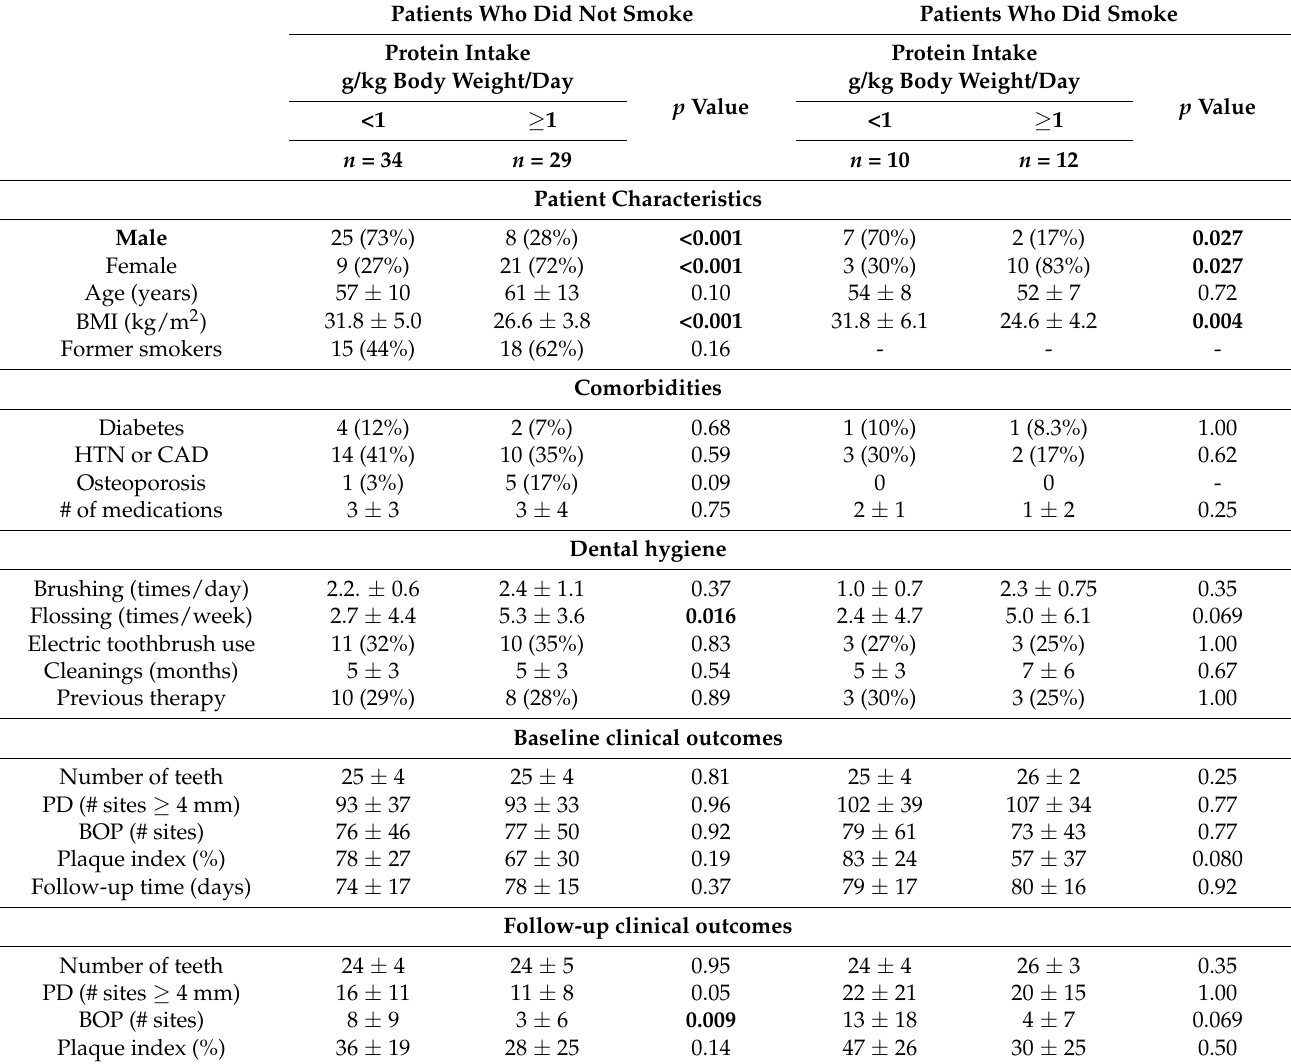
Table 1. Descriptive statistics and clinical parameters of patients undergoing non-surgical periodontal therapy grouped by protein intake and current smoking status 1